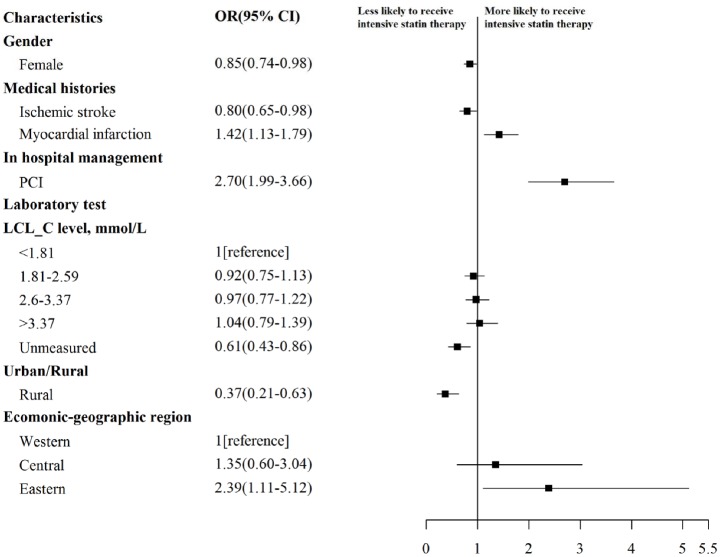
Factors Independently Associated with Intensive Statin Therapy in 2011.Variables with significant association with usage of intensive statin therapy are shown along the vertical axis. The strength of effect is shown along the horizontal axis with the vertical dotted line demarking an odds ratio of 1 (that is, no association); estimates to the right (that is, >1) are associated with greater likelihood of early statin use, while those to the left (that is, <1) indicate association with reduced likelihood of early statin use. Each square and line represents the point estimate of the effect of that variable in the model, while the line shows the 95% confidence interval.